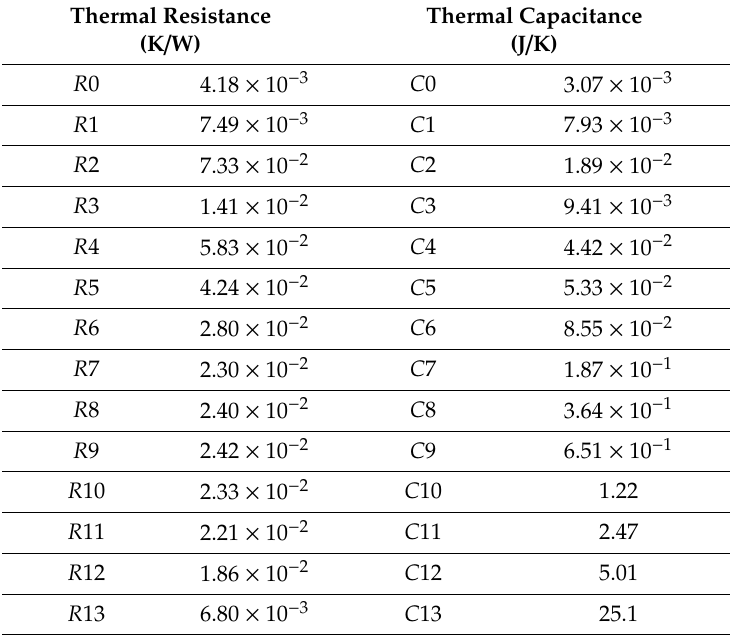
Table 2. Thermal resistance and capacitance values representing the thermal impedance between the SiC MOSFET junction and the SiC power module case (reference